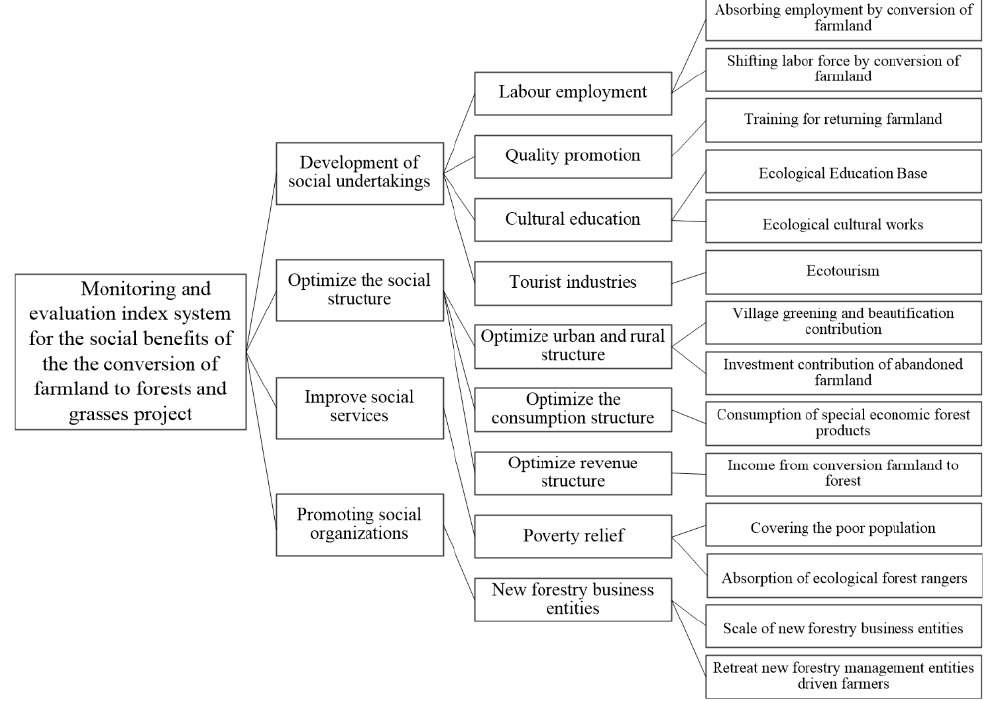
Figure 3. Monitoring and evaluation index system for the social benefits of the CFFG project.